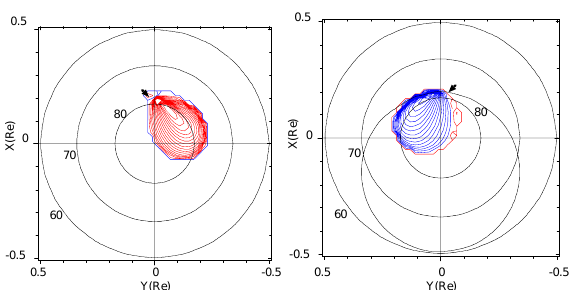
Figure 9. Case 1. Left: The ionospheric electrostatic potential patterns in the northern polar cap are calculated at the time of case 1. The numbers denote the potential relative to the zero equipotential curves (which corresponds to the Sun-Earth line) with a contour separation of 16 kV. Only a single clockwise lobe cell shows up because a second minor counterclockwise lobe is very small for this event IMF direction. The arrow marks the ionospheric projection of the cusp. Right: The ionospheric electrostatic potential patterns in the southern polar cap are calculated for the case 1. Potential drop between two lines is 16 kV. The solid circle shows the auroral oval boundary calculated for IMF=0. The equatorward boundary of the auroral oval corresponds to the inner edge of the tail current sheet. Only a single counterclockwise lobe cell shows up because a second minor clockwise lobe is very small for this event IMF direction. The arrow marks the ionospheric projection of the cusp.